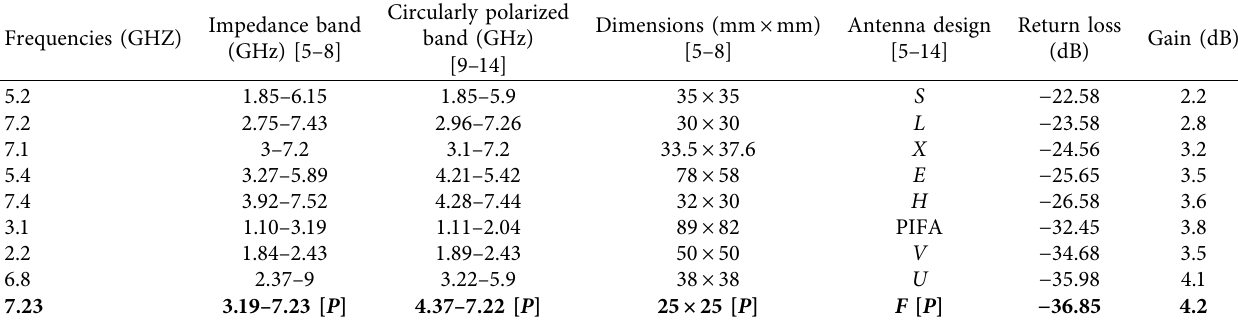
Table 2: Te antenna’s performance is compared to that of previously reported